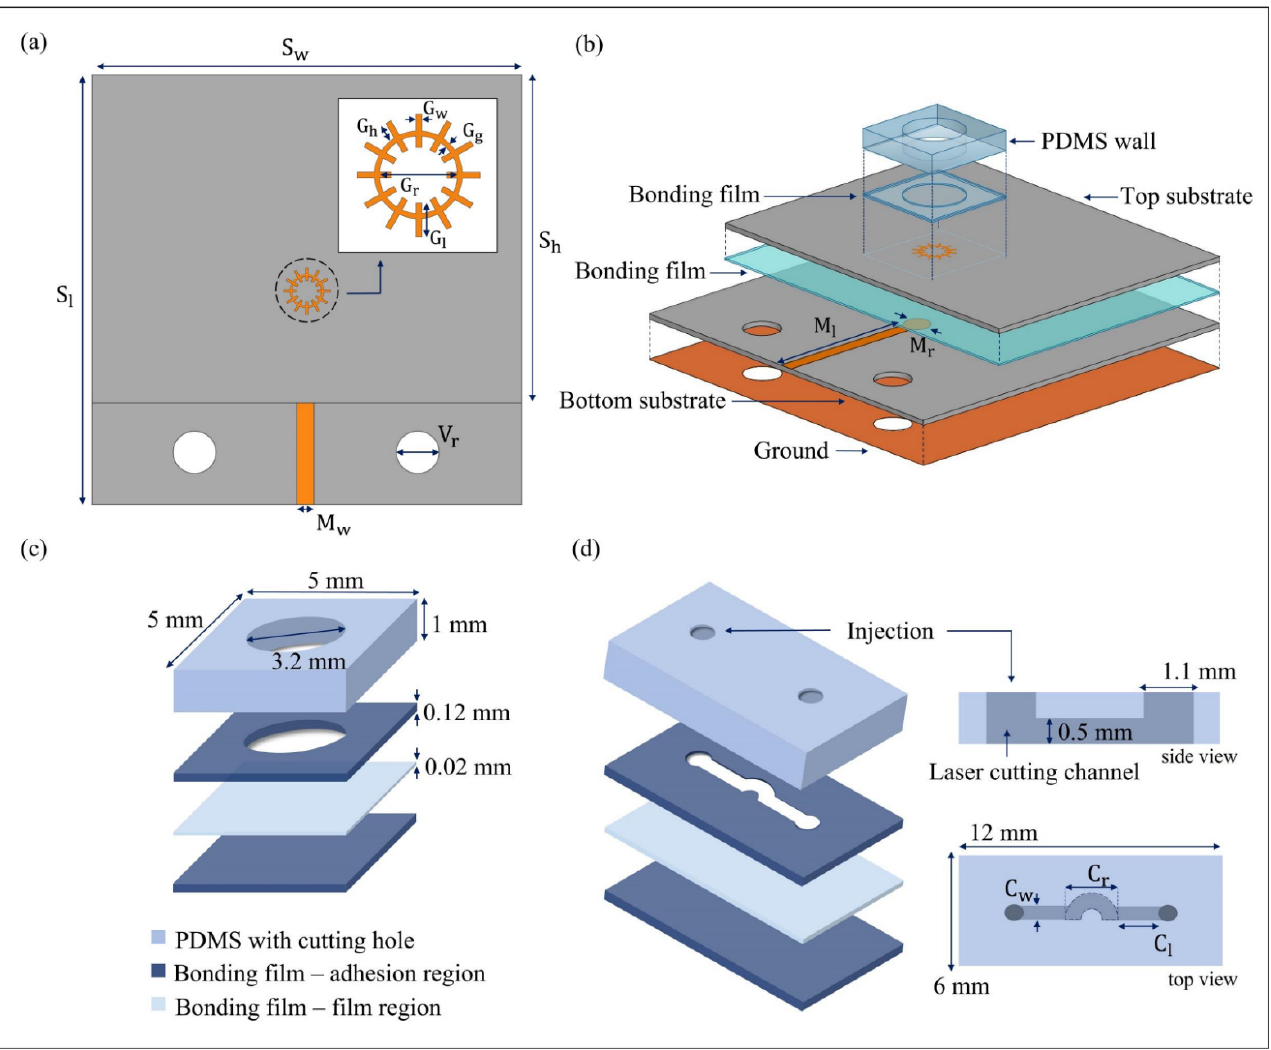
Figure 2. Schematic of the proposed sensor and PDMS channel. ( a ) Top view of the sensor and magnified design of the spoof LSP resonator. ( b ) Layer design of the sensor with microfluidic channels and their alignments. ( c ) PDMS wall and bonding film layer. ( d ) Detailed PDMS-channel design showing the bonding film layer.